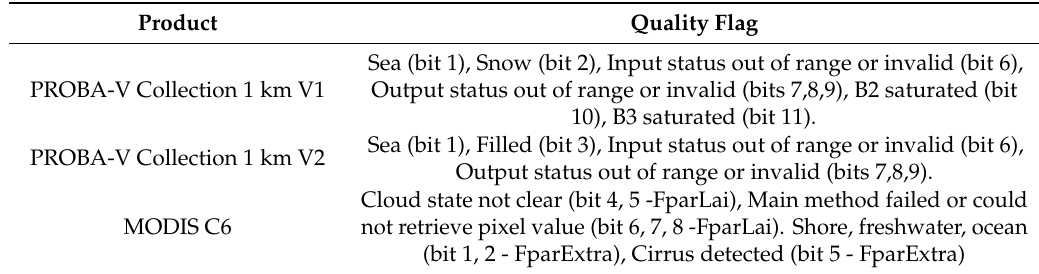
Table 1. Quality flag information used to filter low quality or invalid